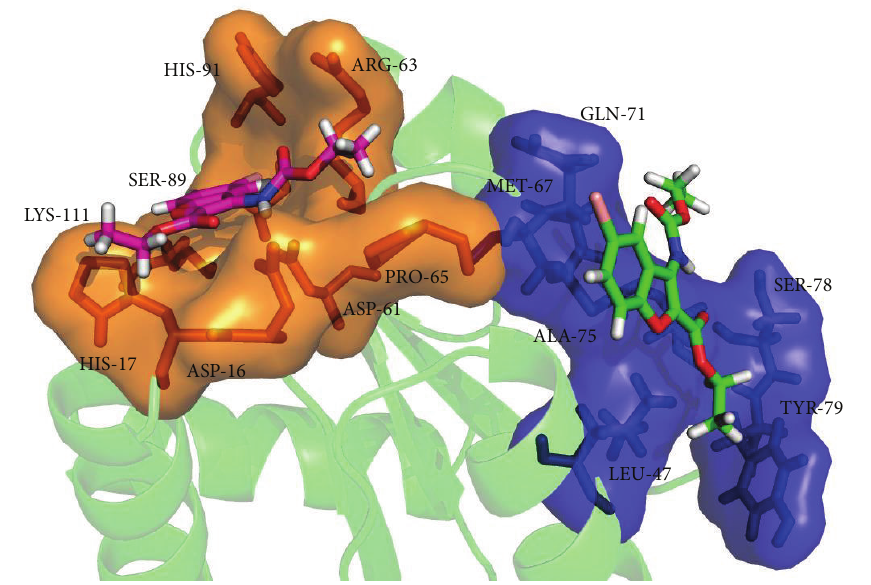
Figure 9: Movement of ligand C7 interaction from pocket-1 (orange) to pocket-2 (blue).